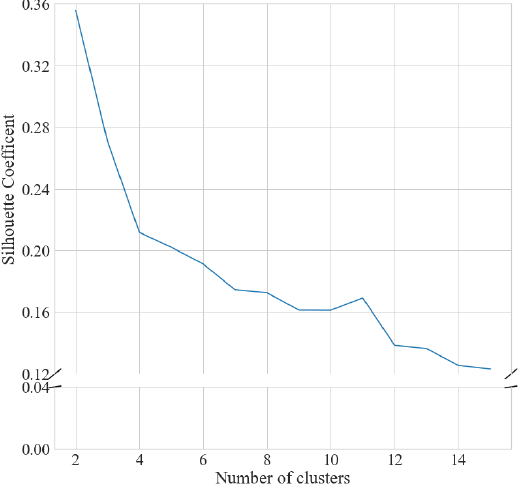
Figure 2. Silhouette analysis for k-means clustering of yearlong step behaviour.